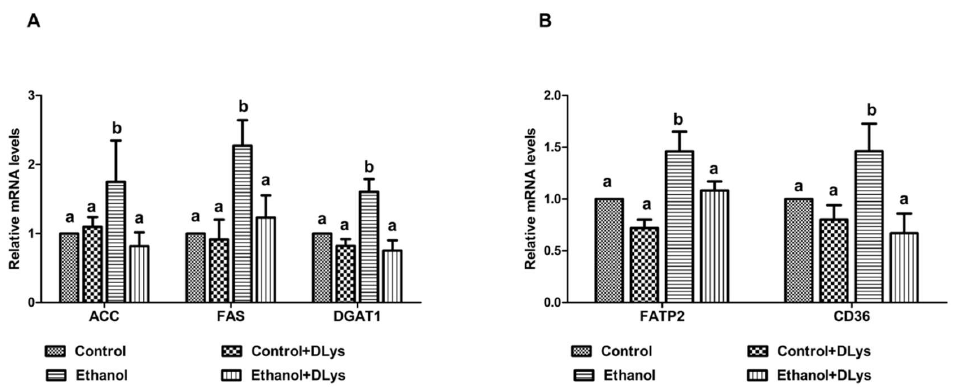
Figure 5. Quantitative analysis of hepatic fatty acid uptake and synthesis. ( A ) qRT–PCR analysis of hepatic gene expression related to fatty acid synthesis-acetyl-CoA carboxylase (ACC), fatty acid synthase (FAS), and diacylglyceride acyltransferase (DGAT1). ( B ) Hepatic gene expression related to fatty acid transport—FATP2 (fatty acid transport protein 2) and fatty acid translocase CD36. Values expressed as a relative to the control values. Values are means ± SEM, n = 8. Values not sharing a common letter are statistically different, p ≤ 0.05.